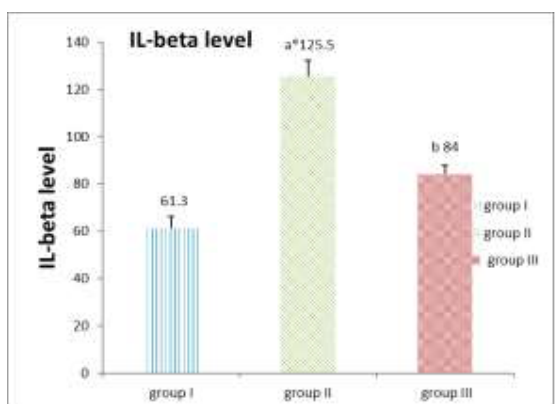
Figure 1. Effect of vinpocetine on TNF-α levels in brain tissue homogenate after IP injection of lead acetate in rats.